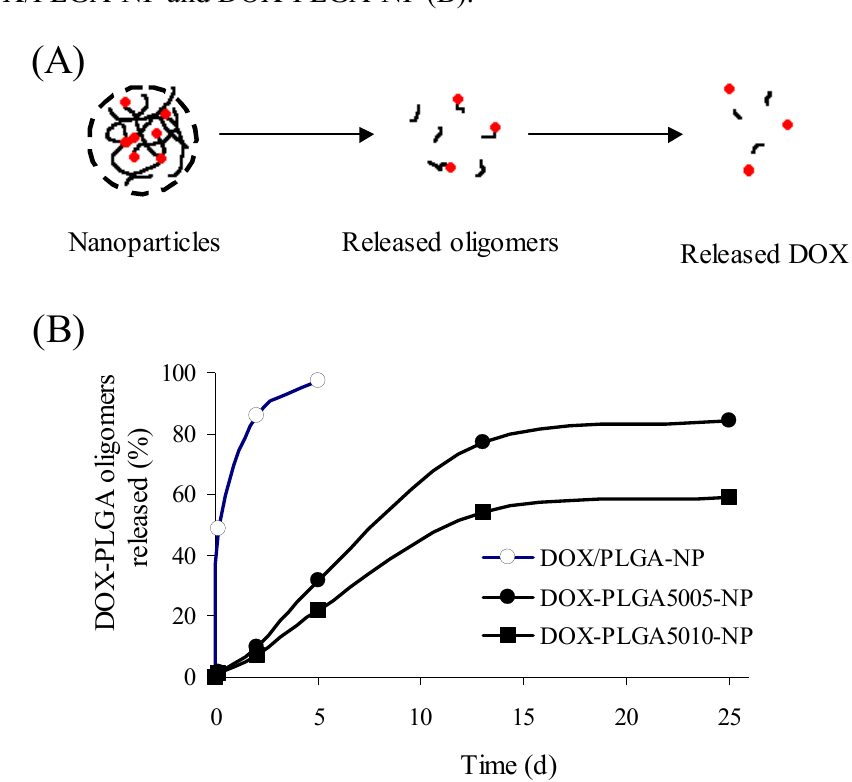
Figure 5. Release scheme of DOX from DOX-PLGA-NP (A) and release profiles of DOX from DOX/PLGA-NP and DOX-PLGA-NP